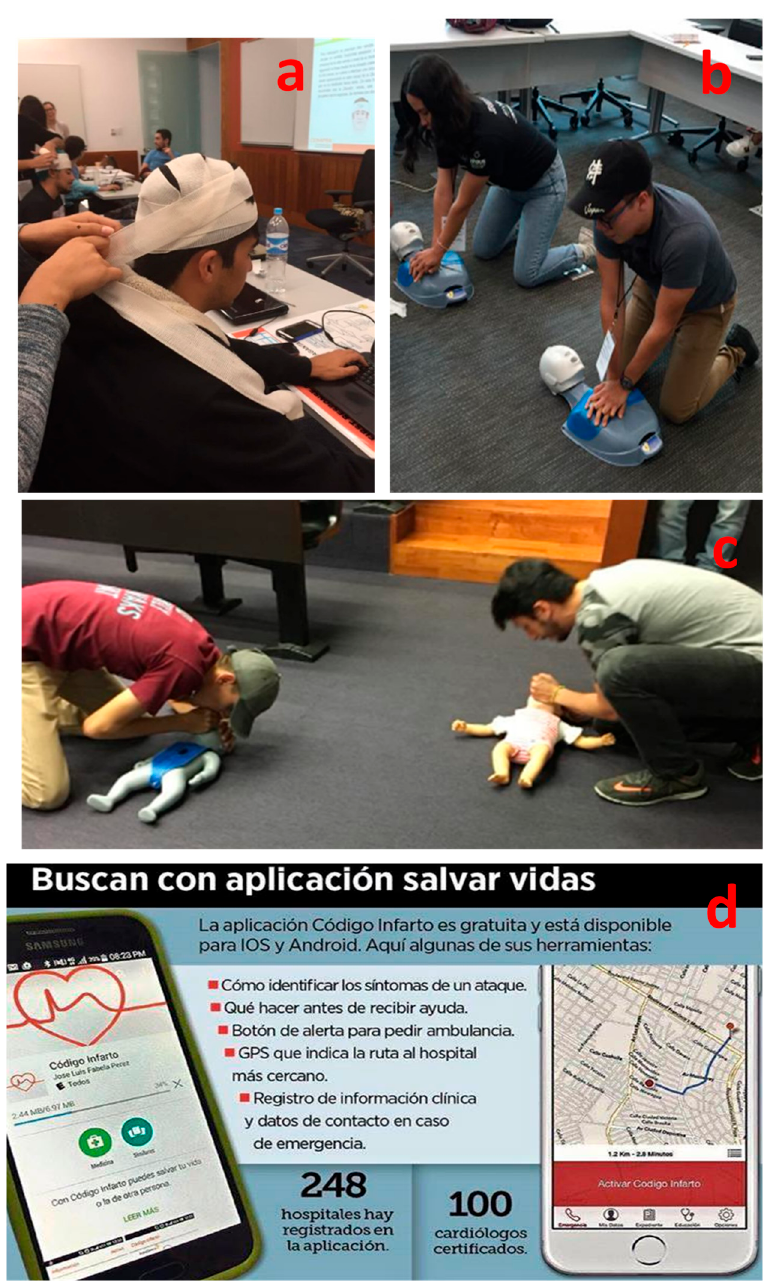
Figure 4. Representative photographs of the theoretical training and practical activities performed in plenary and training sessions during the EFR i-Week at TEC, from 2015 to 2019. ( a ) Photos of practice with bandages during in September 2016. ( b ) CPR training practice and evaluation during the EFR in 2018. ( c ) Same as (b), but for babies. ( d ) One of the leading applications generated during the EFR-2015: “An application to save lives using an app for first responders”.